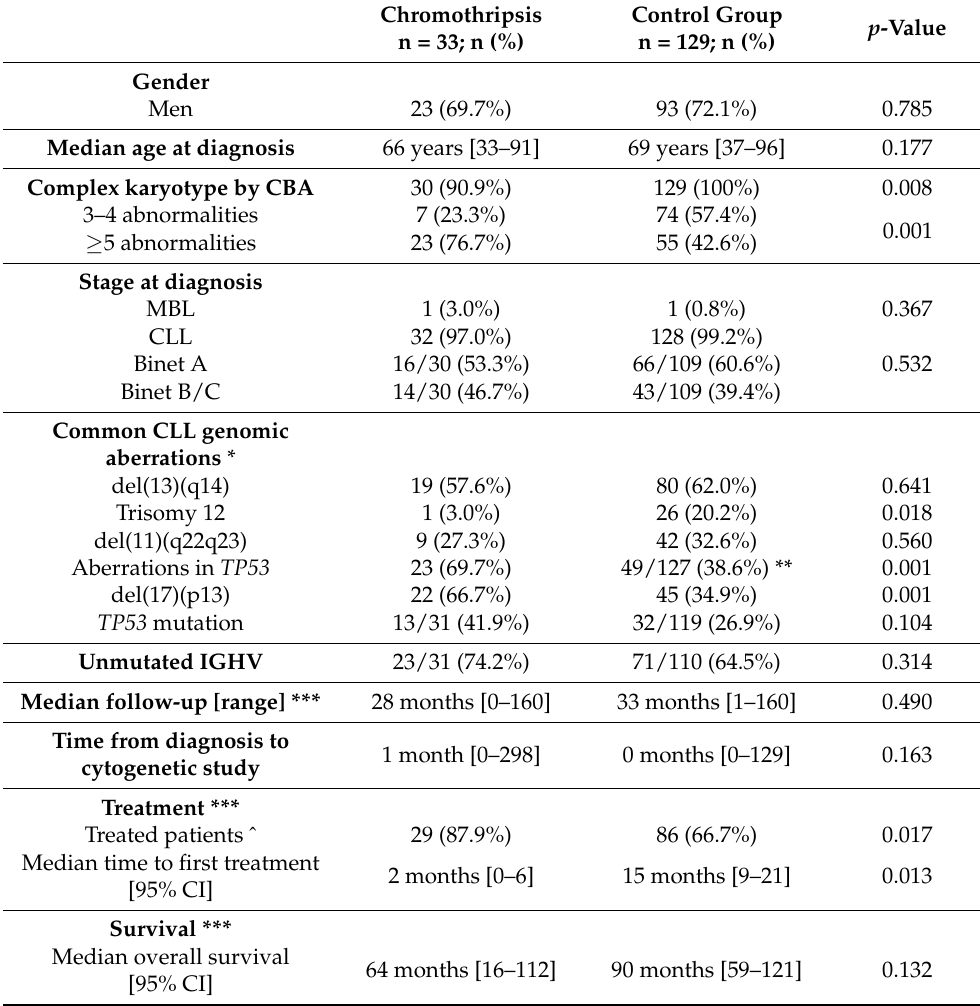
Table 1. Baseline characteristics of patients at diagnosis and last